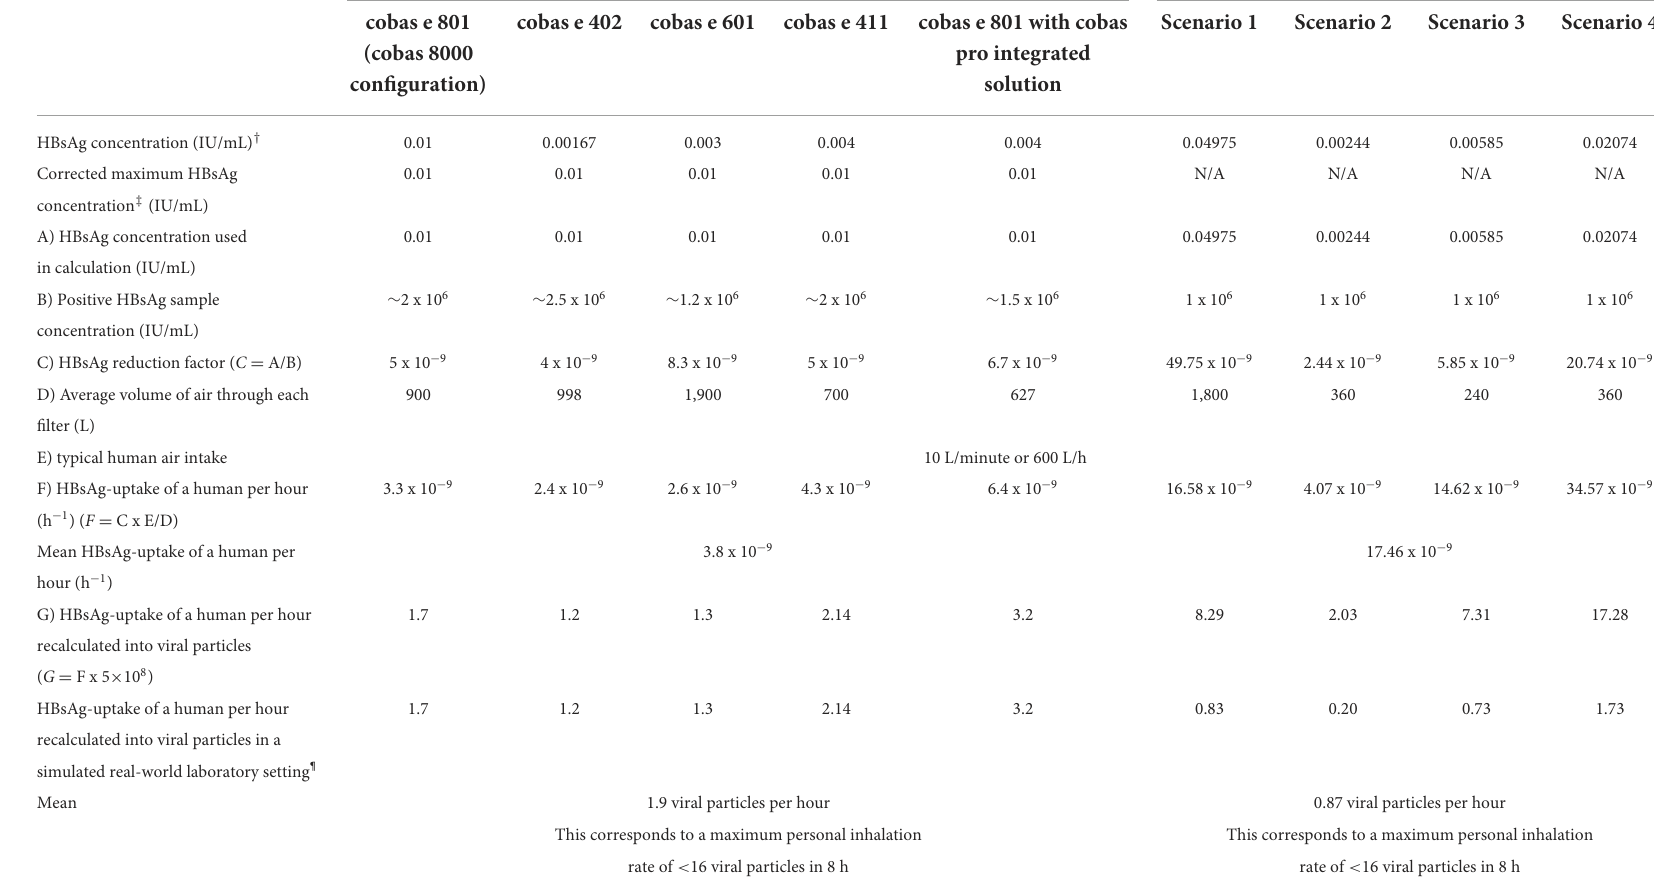
TABLE 1 Overview of the calculations and results for air sampling *